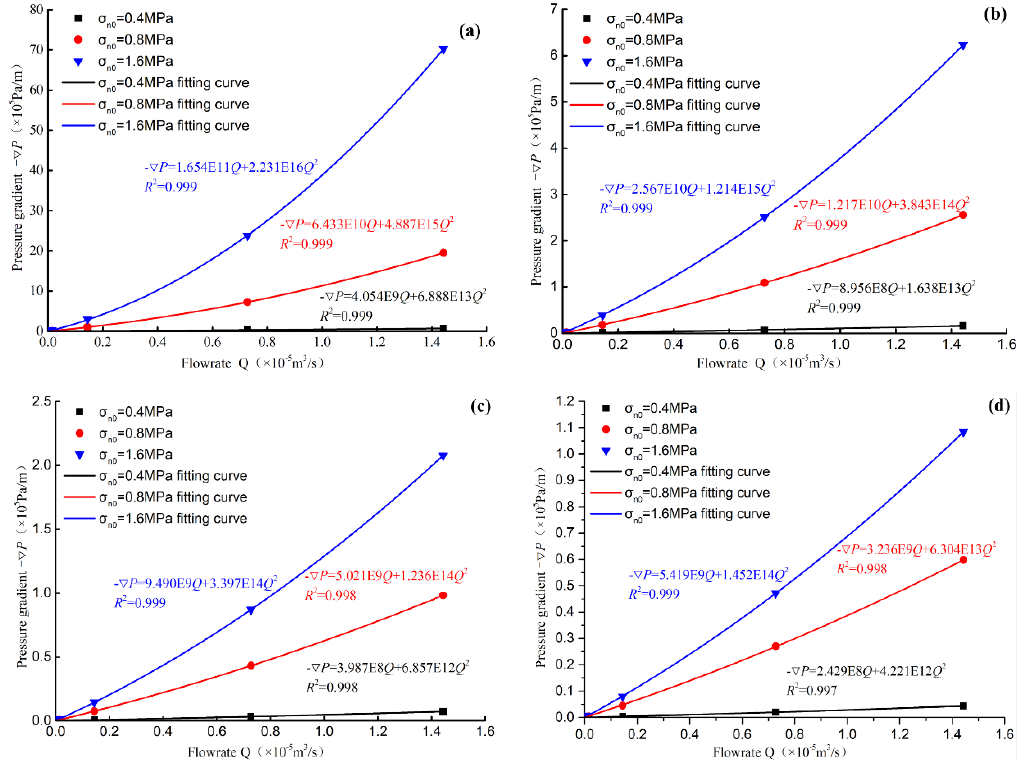
Figure 5. Relationship between pressure gradient and flow rate under different initial normal stresses, ( a ) u h = 4 mm; ( b ) u h = 6 mm; ( c ) u h = 8 mm; ( d ) u h = 10 mm.